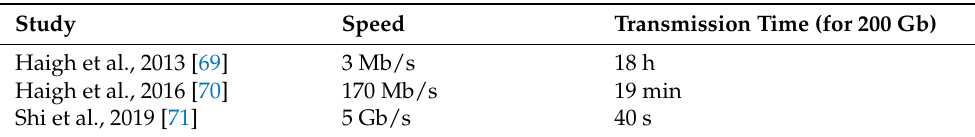
Table 2. Transmission speed of some VLC